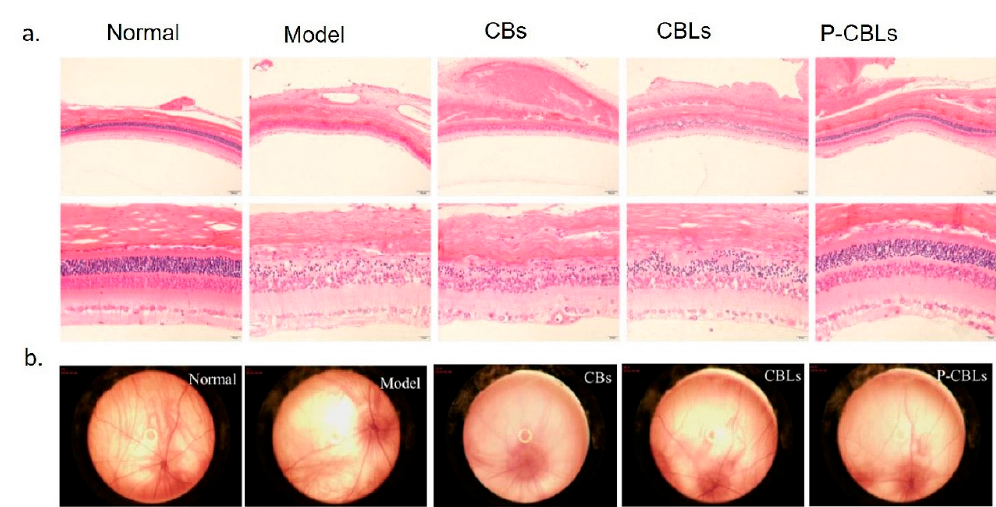
Figure 4. ( A ) Protection evaluation against photo-oxidative retinal damage in a light-damaged